Question: Author a descriptive caption for the visualization shown.
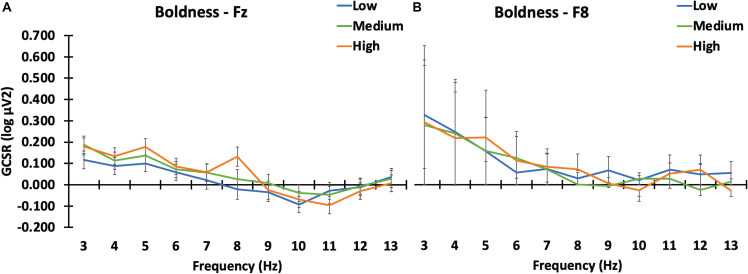
Answer: EEG power of boldness groups on GCSR at Fz and F8 . Note : The Y axis represents the EEG power (log µV 2 ) for the GIS (GCSR) measure. Boldness groups are: low (blue); medium (green; and high (orange). The X-axis is the frequency (Hz). A . Findings at Fz. B . findings at F8. Error bars represent standard error.